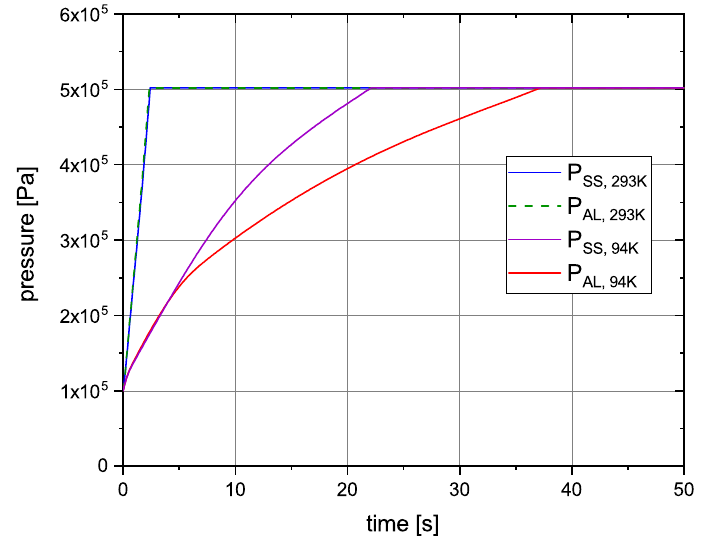
Figure 6. Pressure inside cryogenic